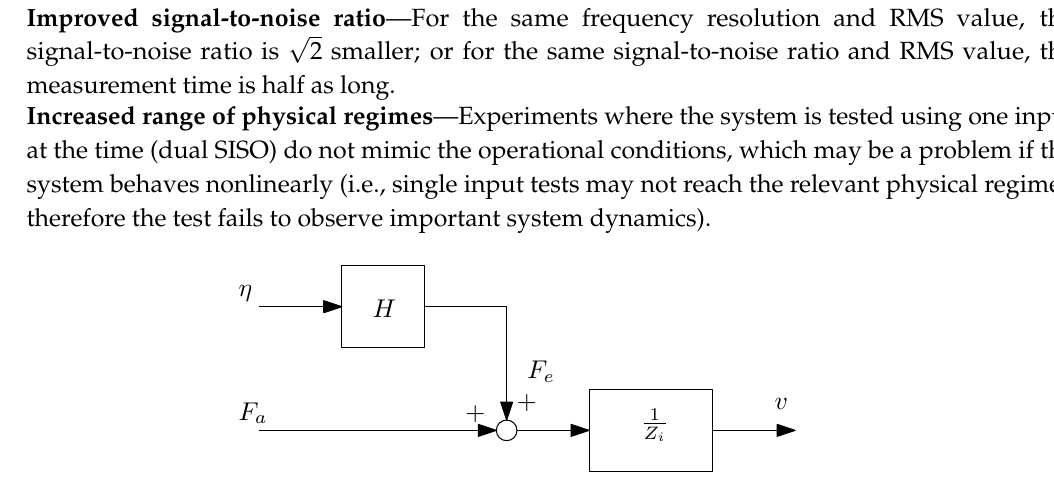
Figure 2. Block diagram of the WEC base on radiation/diffraction model. The surface elevation is denoted by η , the actuator force is F a and the velocity is v